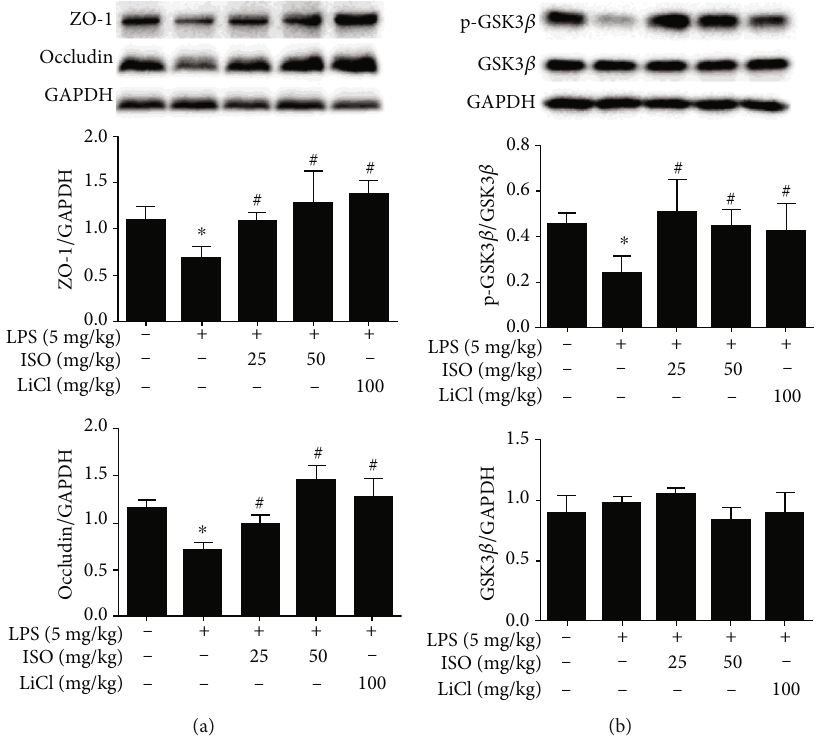
Figure 5: E ff ects of isoorientin on ZO-1 (a), occludin (a), and p-GSK3 β (b) in the brain of endotoxemia mice. Isoorientin (25 and 50 mg/kg, ig) and LiCl (100mg/kg, ig) were given once a day for 5 days, and after 30min of the last administration, LPS (5 mg/kg, ip) was given. The brain tissues were collected after 6 h of LPS injection. Western blotting was used to measure the expression of ZO-1, occludin, p-GSK3 β , and GSK3 β . The data were expressed as mean ± SEM ( n = 3 , 3 biological replicates). Statistical analysis was done using ANOVA. ∗ P < 0 : 05 versus the control group, # P < 0 : 05 versus the LPS